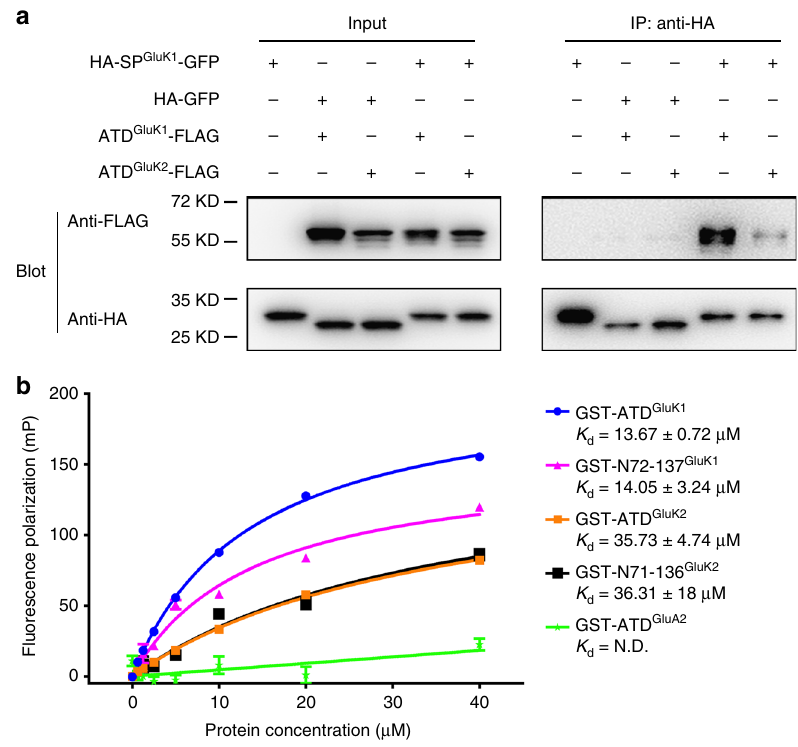
Fig. 4 The GluK1 signal peptide interacts with the ATD. a Immunoblots of immunoprecipitates from transfected HEK 293T cells lysates. The transfected constructs are indicated above each lane. Recombinant protein HA-GFP was used as a control for HA-SP GluK1 -GFP, which lacks the GluK1 signal sequence in mature protein. HA-GFP, ATD GluK1 -FLAG, and ATD GluK2 -FLAG were driven by GluK2 signal peptide to ensure they were synthesized in ER pathway. b Fluorescence polarization (FP) analyses of peptide-protein. FITC-labeled GluK1 signal peptide (100 nM) was titrated with increasing concentrations of indicated GST-fusion proteins, and changes in FP were monitored and the apparent K d values (mean ± SEM) were determined from three experiments. N.D., not determined for GST-ATD